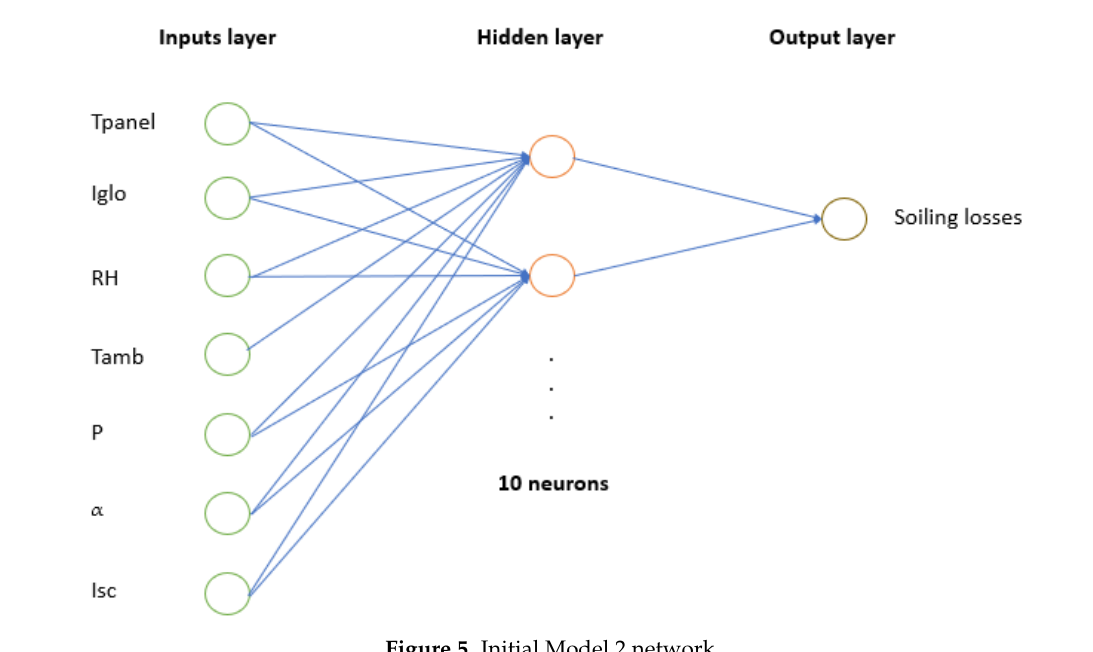
Figure 5. Initial Model 2 network.